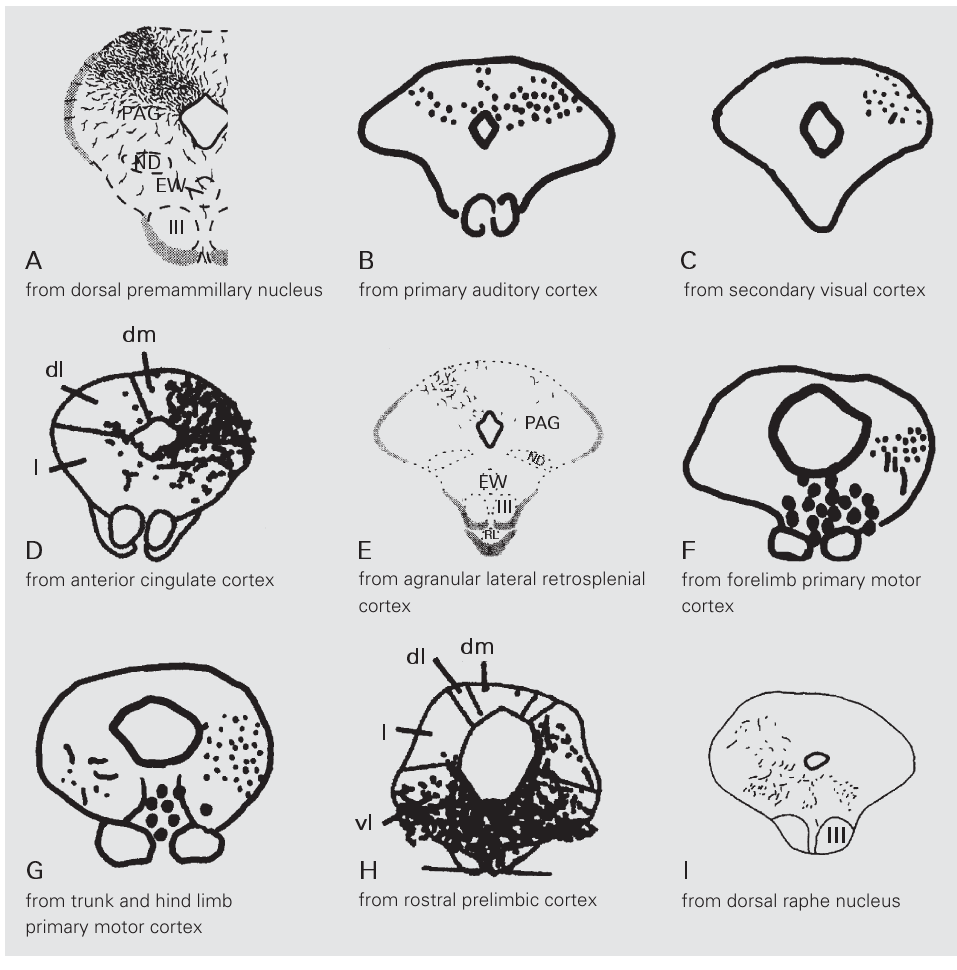
Figure 2. Orthogradely labeled terminations from afferent struc- tures to the periaqueductal gray. Large dots in F and G represent retrogradely labeled neuronal so- mata. III, oculomotor nucleus; dl, dorsolateral periaqueductal gray; dm, dorsomedial periaqueductal gray; EW, Edinger-Westphal nucleus; l, lateral periaqueductal gray; ND, nucleus of